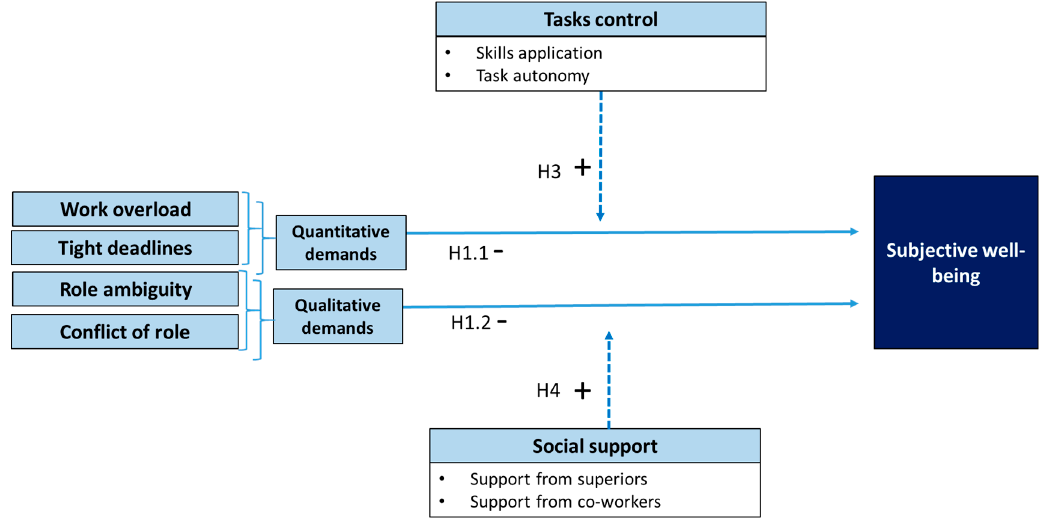
Figure 1. Model of the relationship between job demands, resources, and subjective well-being with a resource-moderating effect.